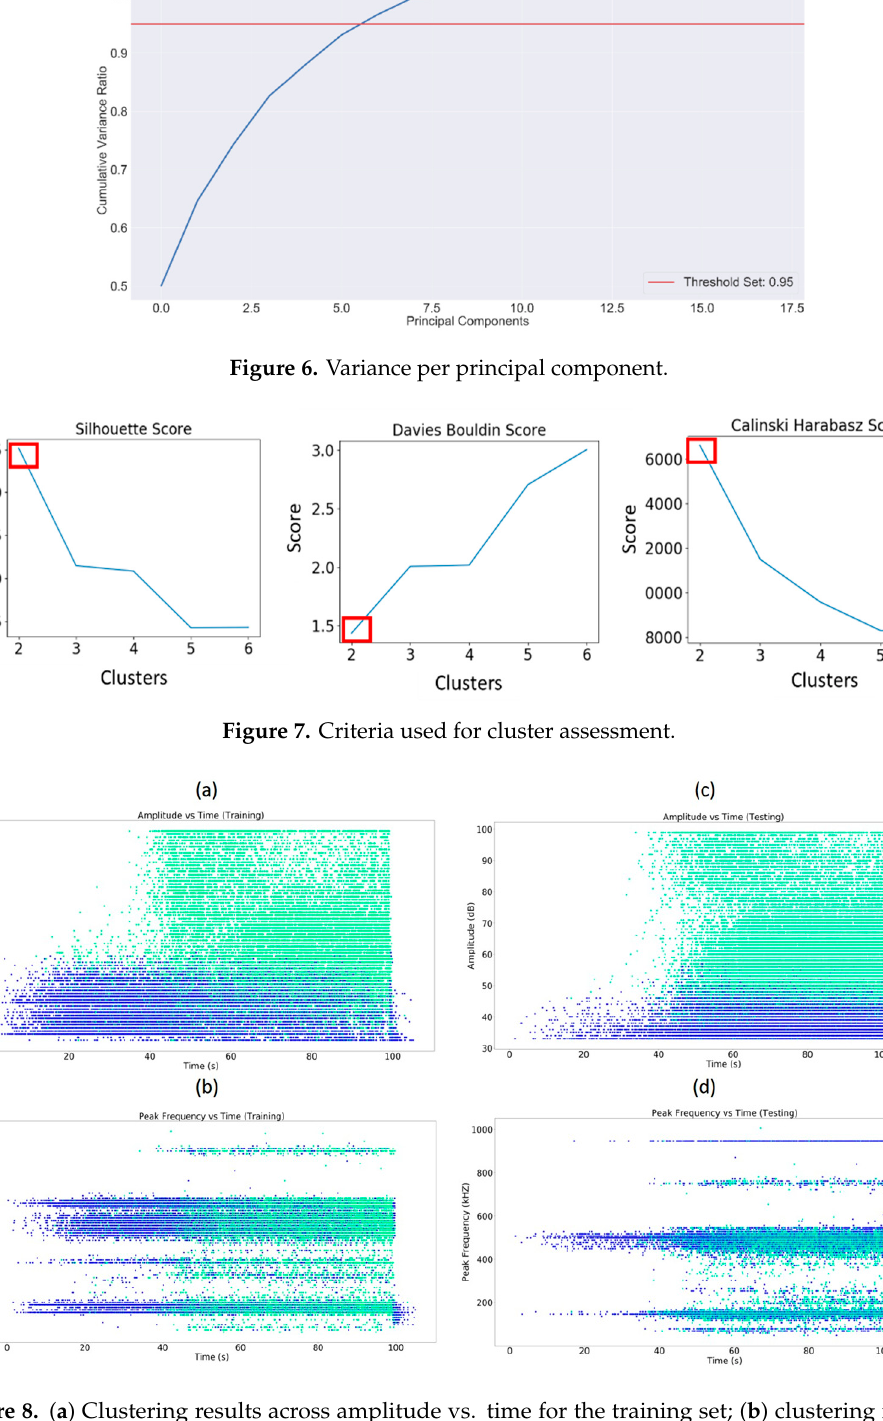
Figure 8. ( a ) Clustering results across amplitude vs. time for the training set; ( b ) clustering results across peak frequency vs. time for the training set; ( c ) classification results across amplitude vs. time for the testing set; ( d ) classification results across peak frequency vs. time for the testing